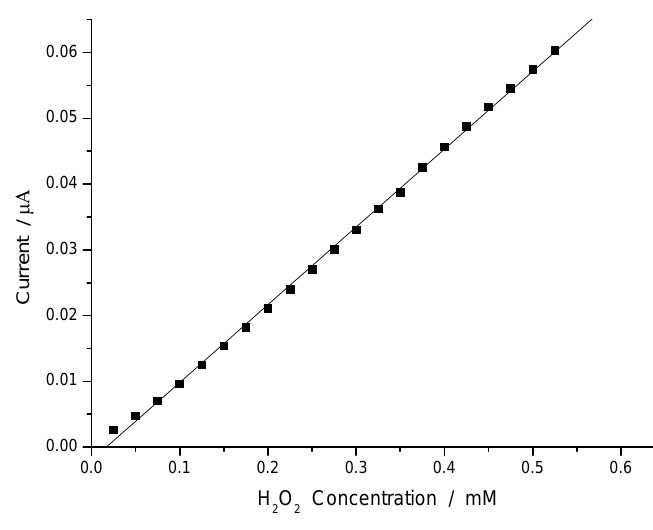
Figure 6 . Calibration plot between current and H